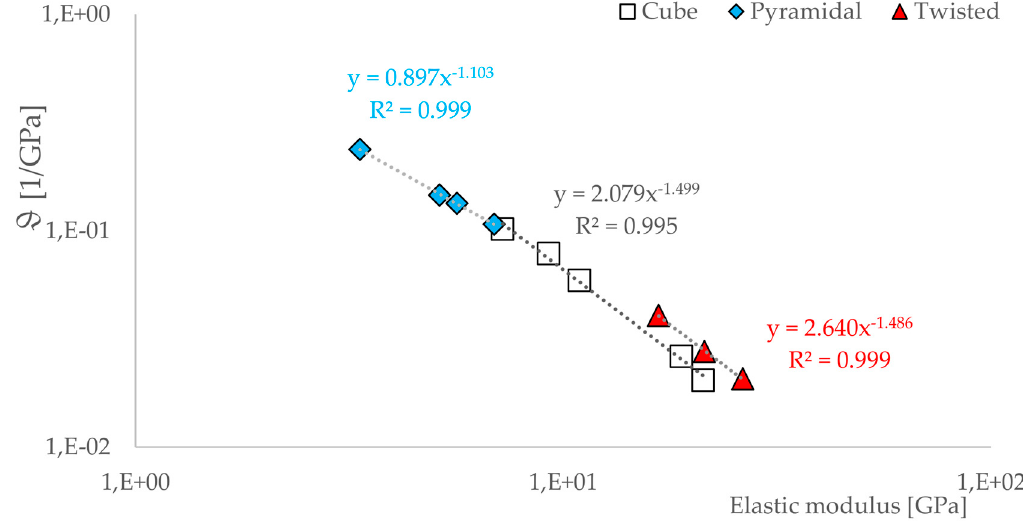
Figure 10. Relationship between elastic modulus for a design and the ratio between porosity and modulus ϑ correlation.